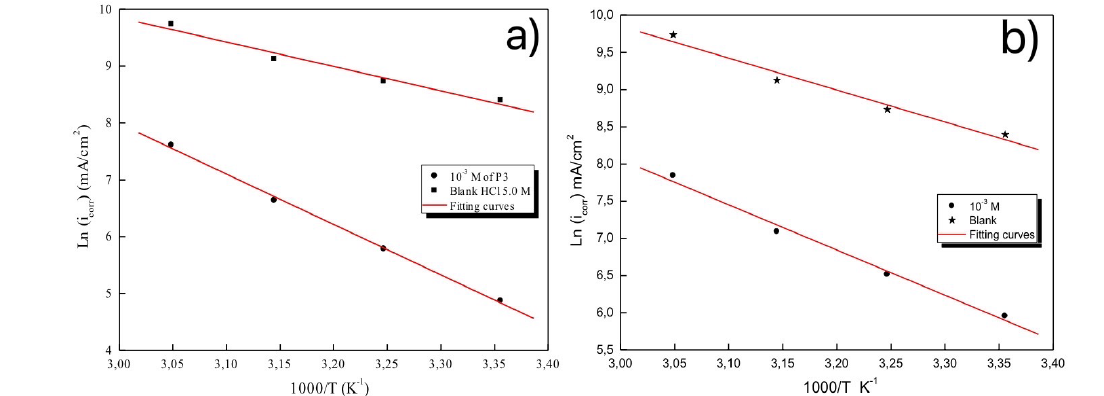
Figure 7. Arrhenius plots of ordinary mild steel in 5.0 M HCl without and with 10-3 M of (a) P3 or (b) P4.